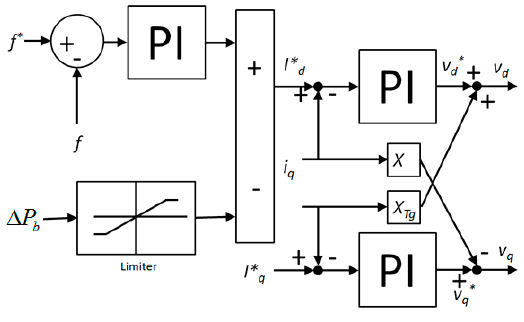
Figure 9. Battery control strategy.